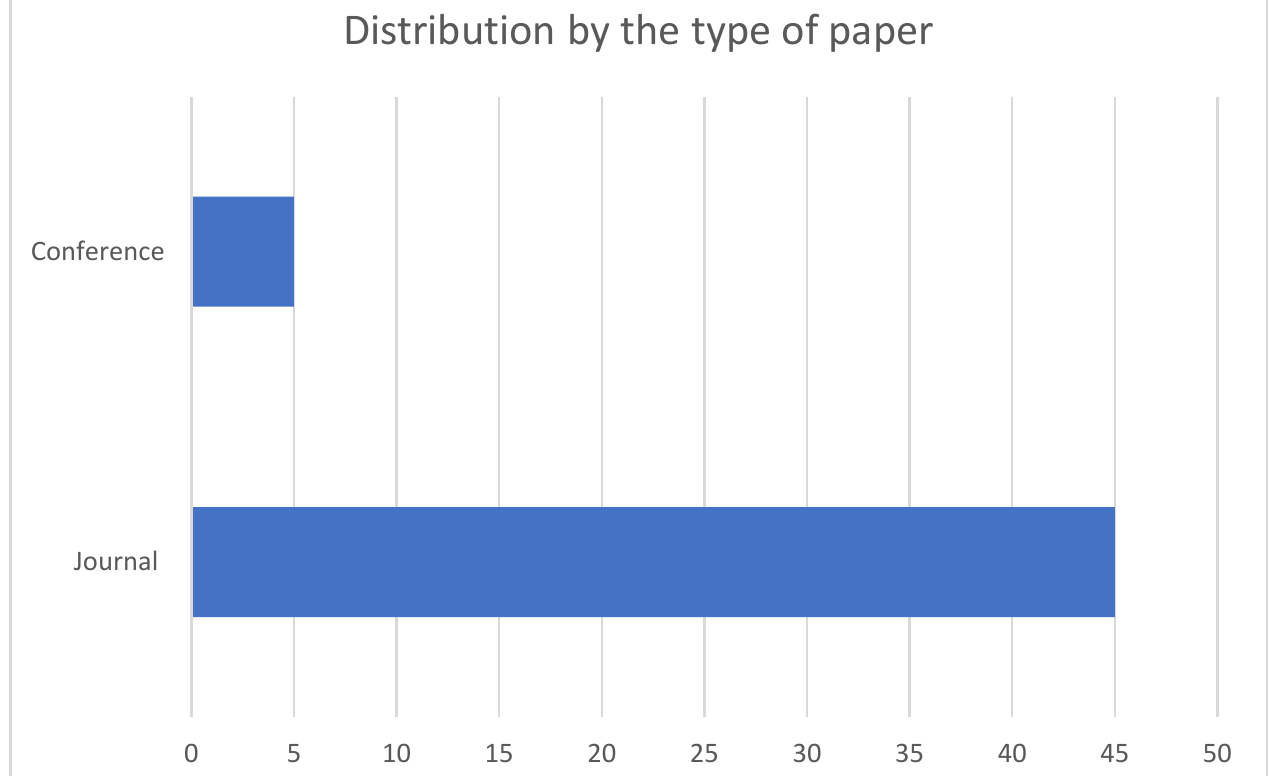
Figure 16. Distribution by the type of paper.